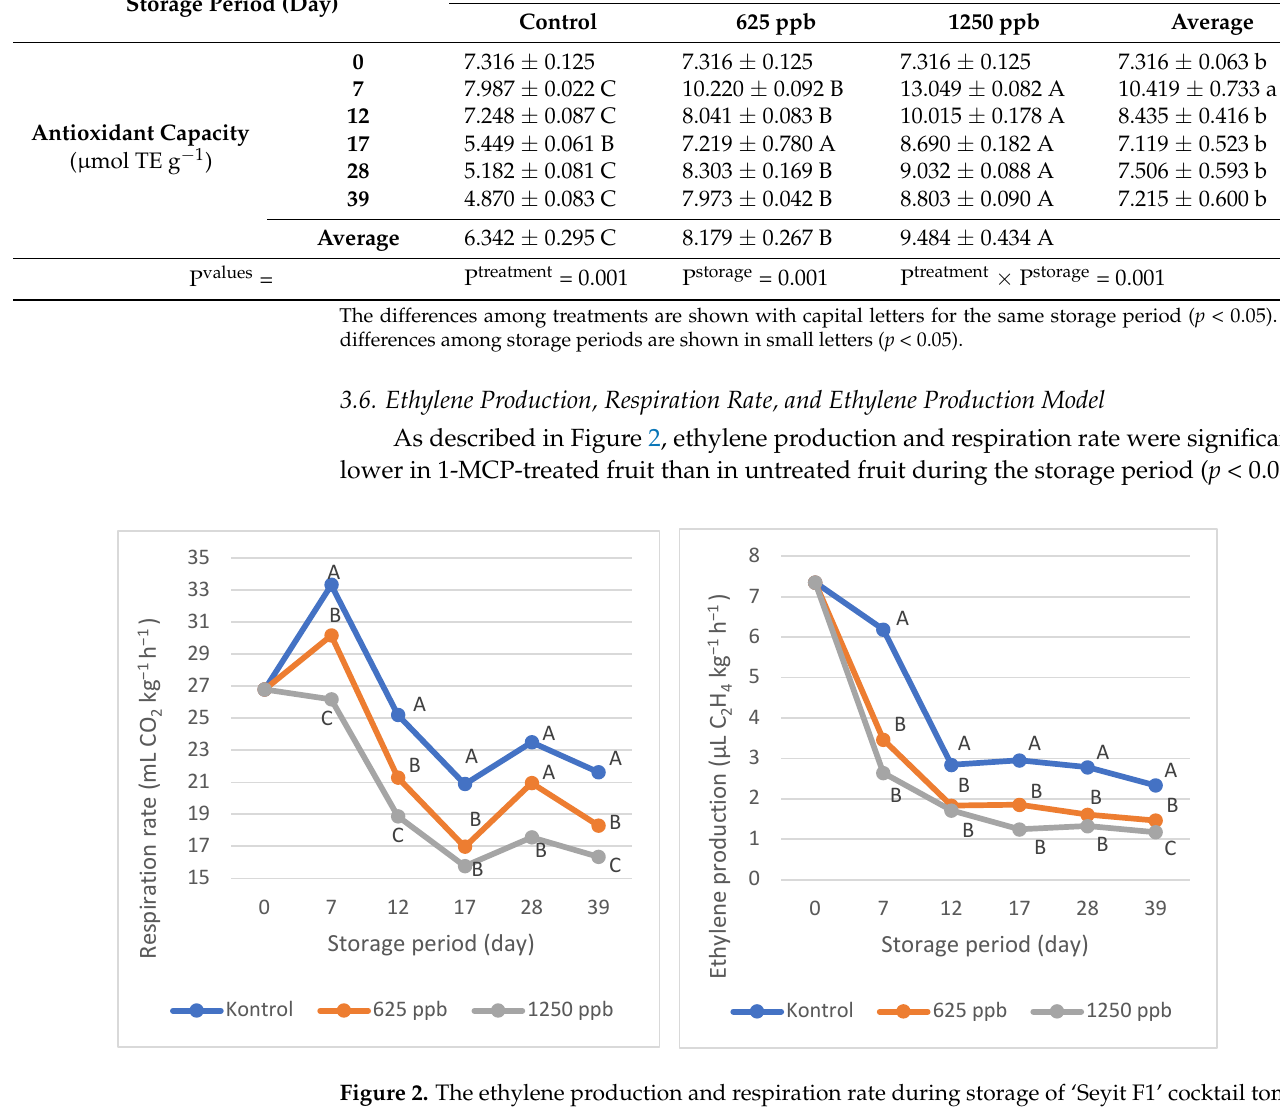
Figure 2. The ethylene production and respiration rate during storage of ‘Seyit F1’ cocktail tomato ( Solanum lycopersicum L.) The differences among treatments are shown with capital letters for the same storage period ( p < 0.05).